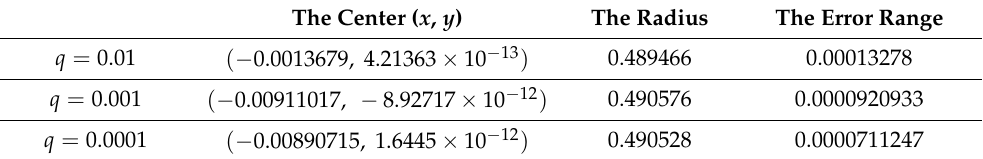
Table 1. The center and radius of the approximated circles of S 50, q ( x ) . The Center ( x , y ) The Radius The Error Range